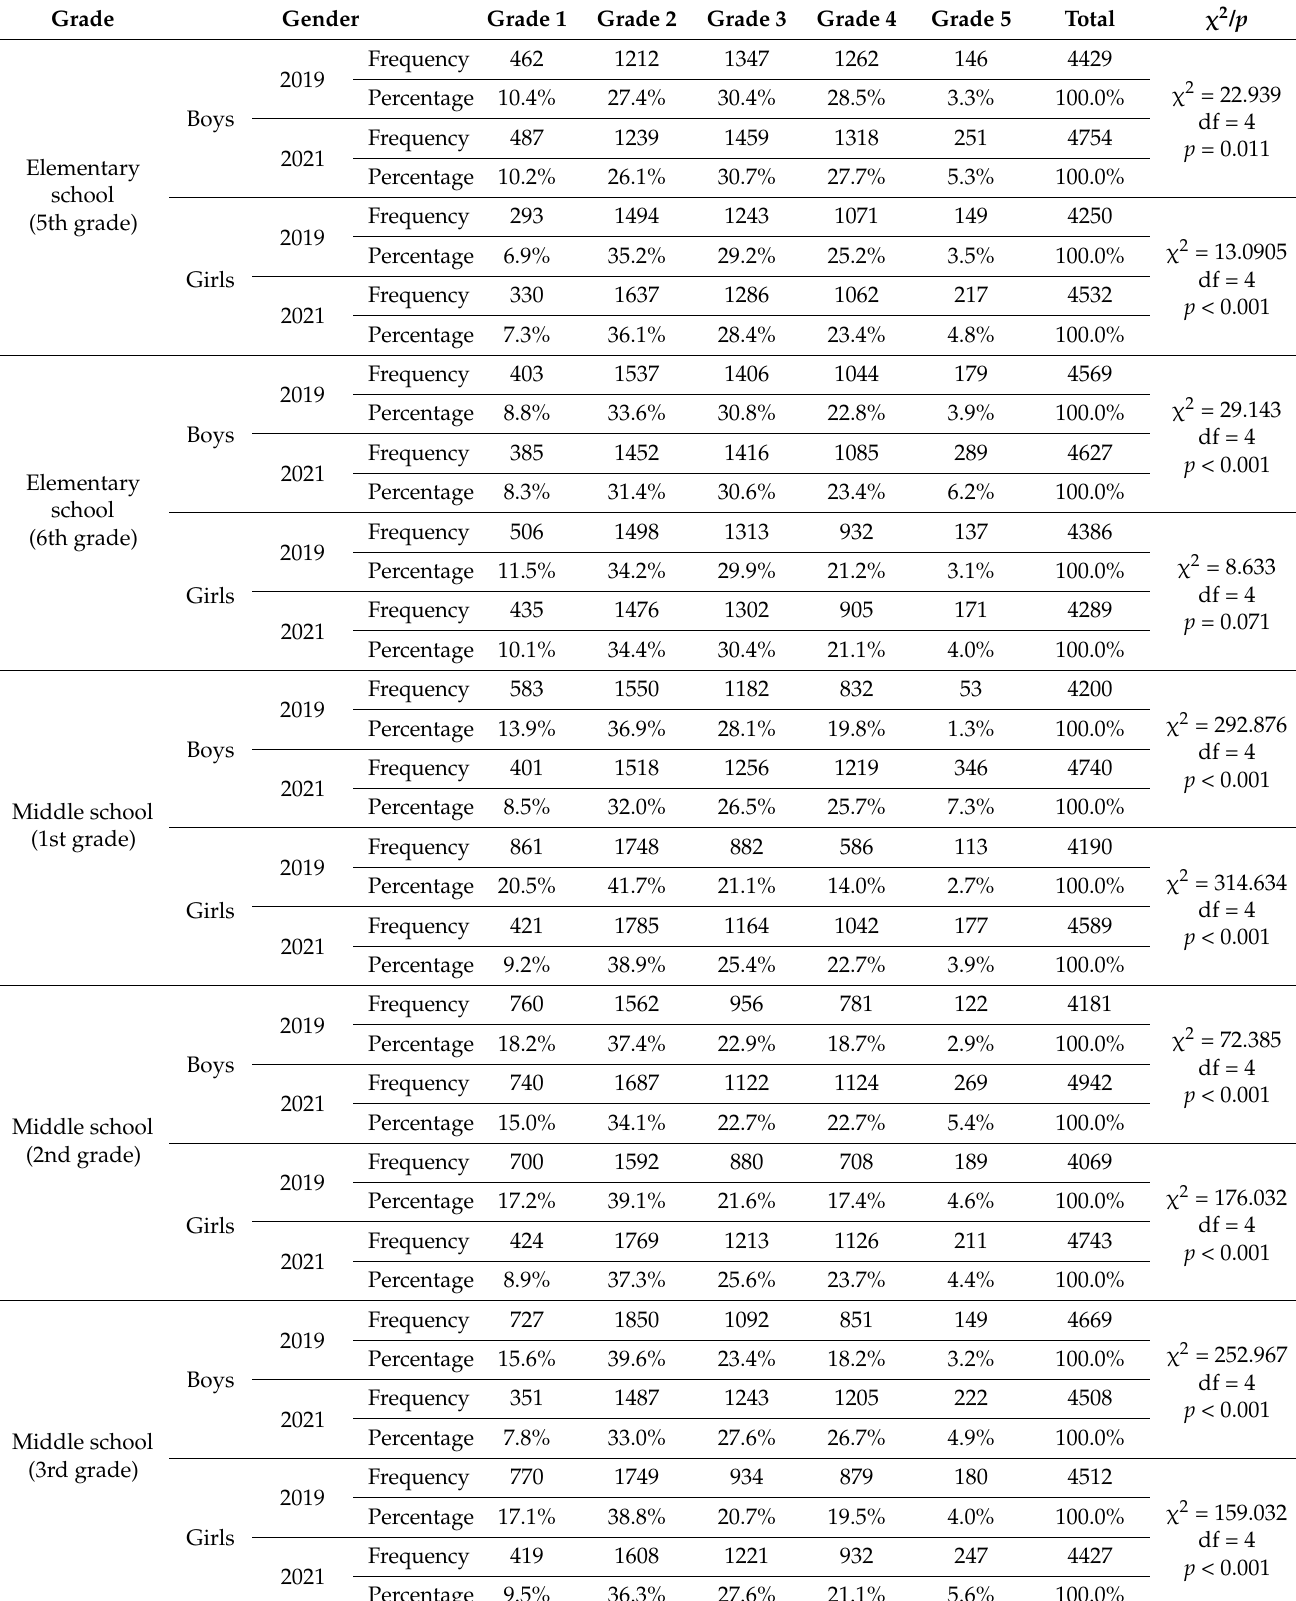
Table 4. Comparison of power in 2019 and